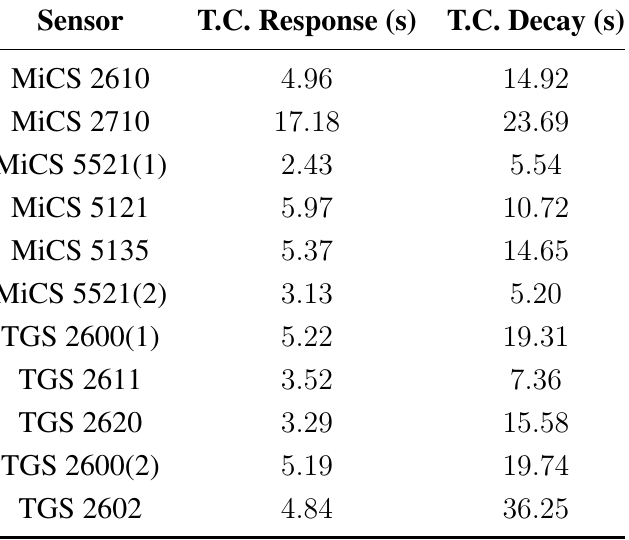
Table 1. Time constants calculated of the rise and decay phase of each sensor. The sensors were used without any modifications to improve response and decay